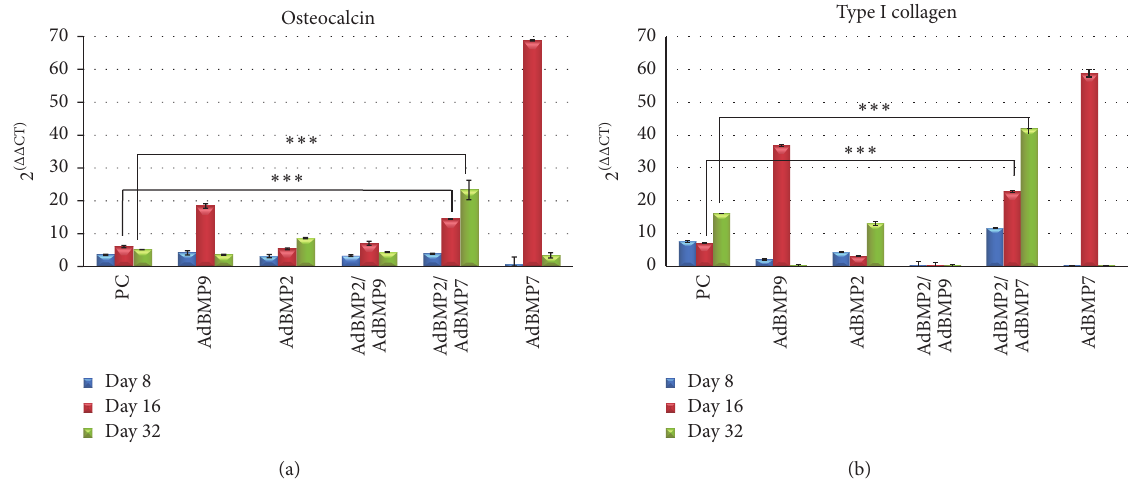
Figure 1: Relative expression analysis of (a) osteocalcin and (b) type I collagen by qPCR of MSCs transduced with AdBMP-2, AdBMP7, AdBMP9, and the combinations AdBMP2/AdBMP7 and AdBMP2/AdBMP9 on days 8, 16, and 32 after induction. The combination AdBMP2/AdBMP7 shows higher levels of osteocalcin and osteopontin and these were maintained for 32 days. ∗∗∗ significance level 𝑃 < 0.05 .